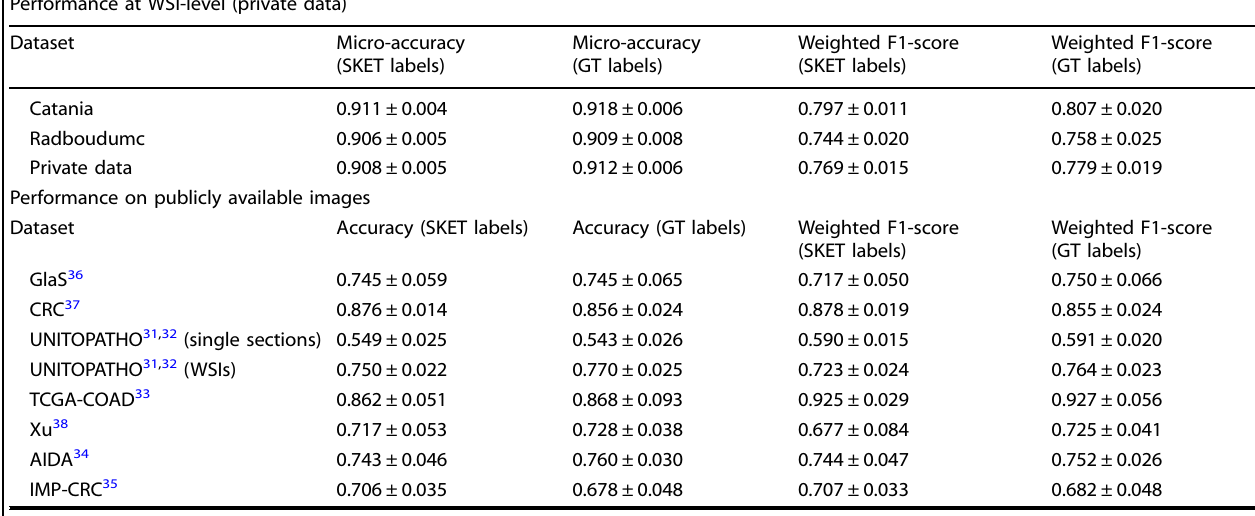
Table 2. CNN performance